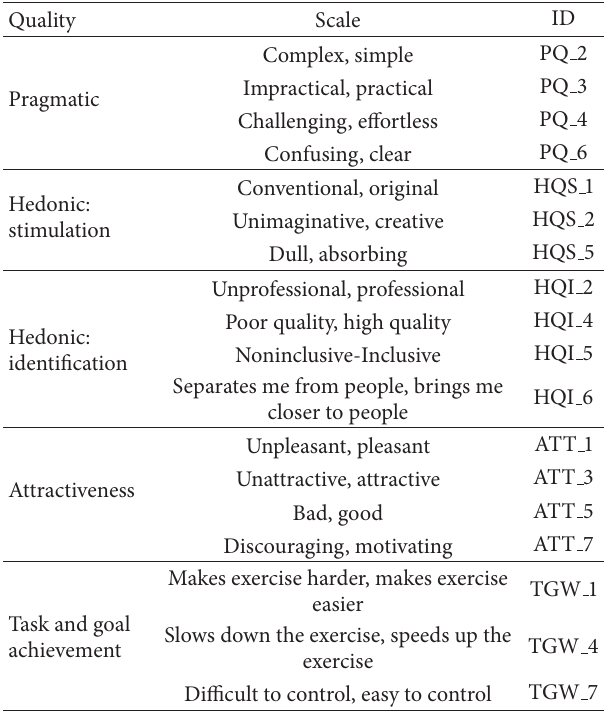
Table 1: Qualities and scales used in the UX